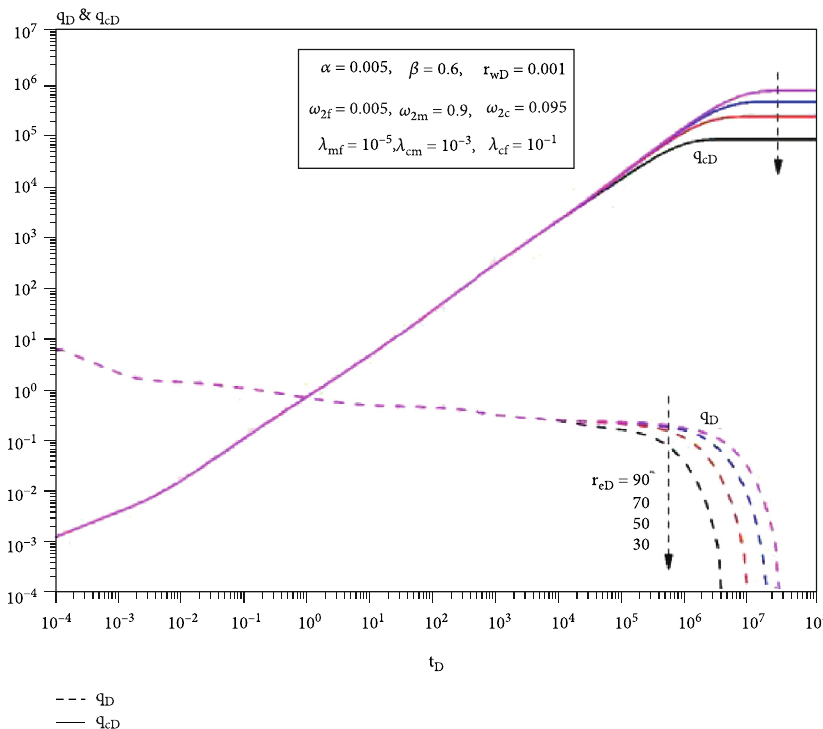
Figure 10: In fl uence of reservoir radius on the production of an AFVW in a pore-cavity-fracture carbonate